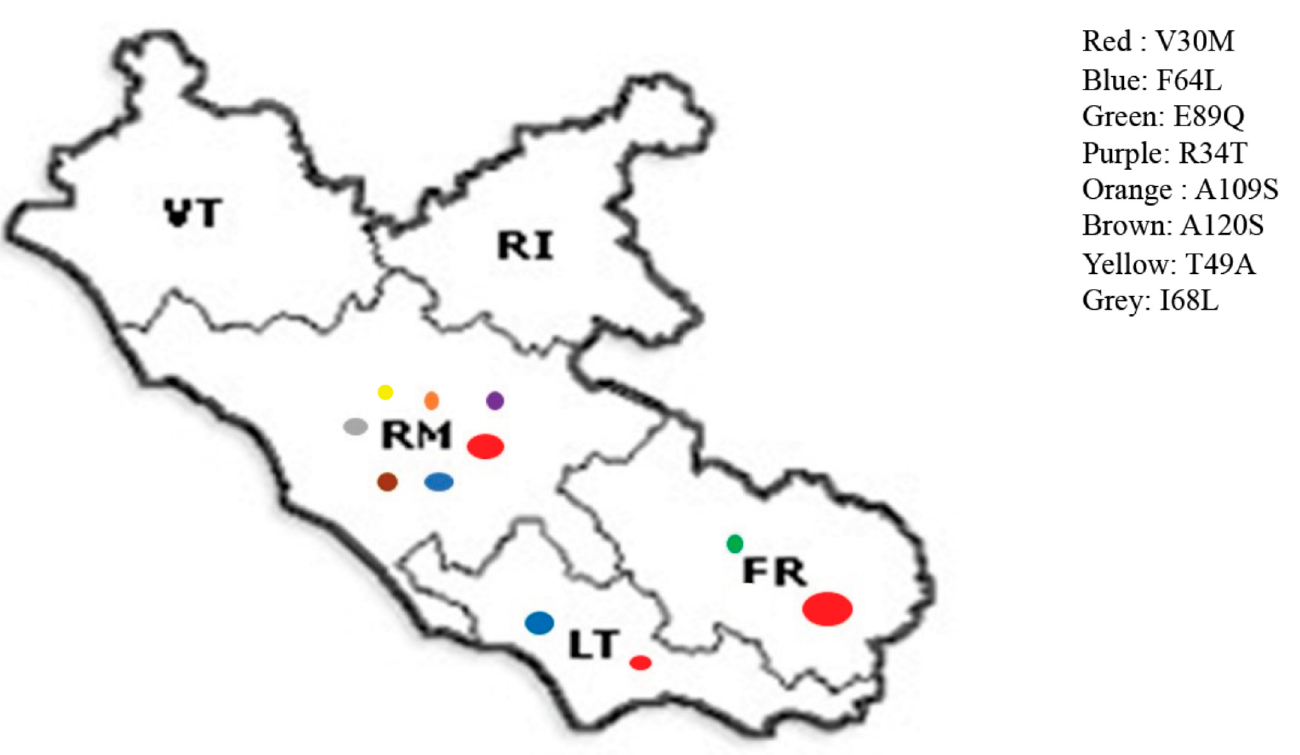
Figure 1. Distribution of TTR mutations in Lazio region among different provinces. Diameter of circles is proportional to number of patients.